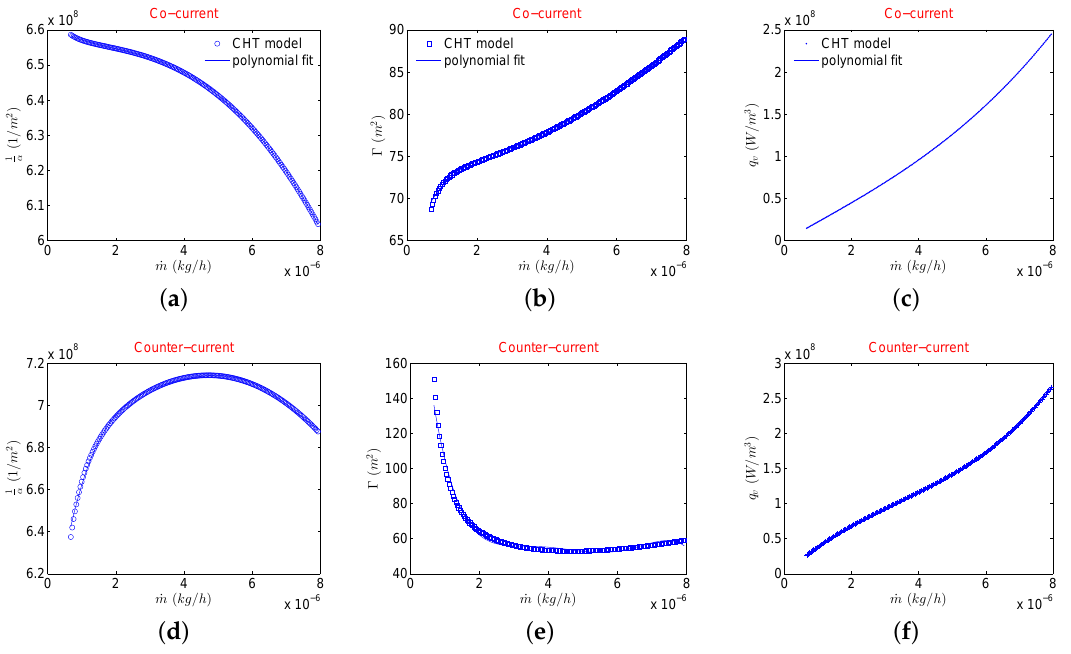
Figure 7. Viscous coefficient ( a , d ), inertial coefficient ( b , e ), and volumetric heat source term ( c , f ) extracted from CHT analysis in both flow